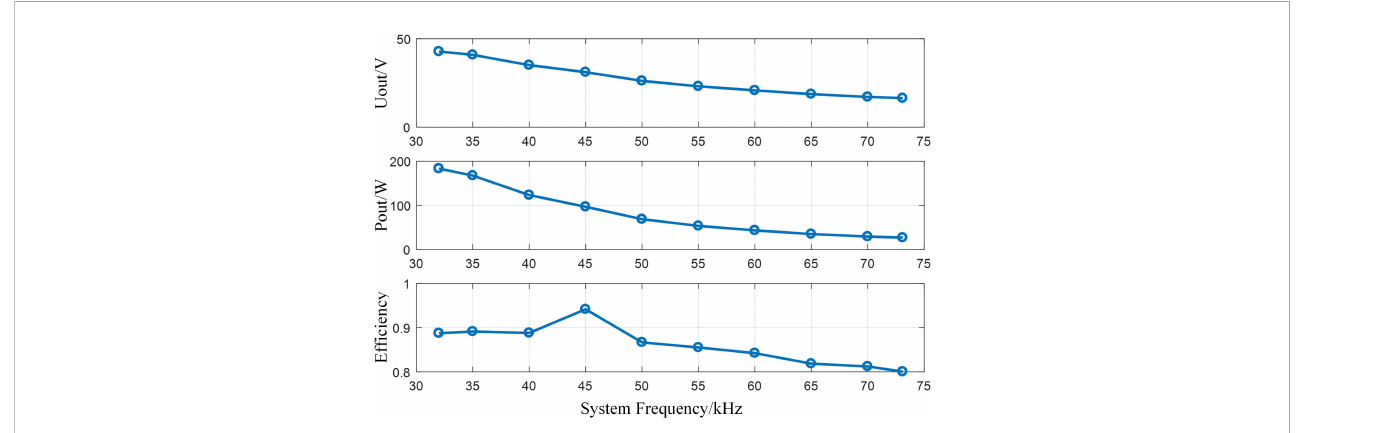
FIGURE 11 Output performance of 10 W resistor under different operating